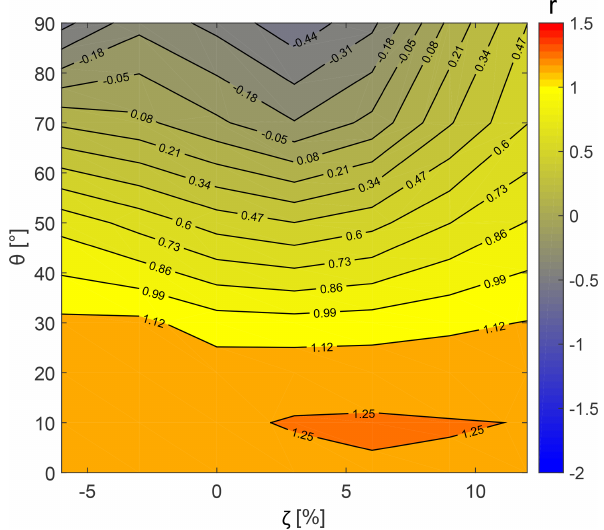
Figure 11. Effect of variable radial gap and the flap deflection angle on the power augmentation factor using the panel method.